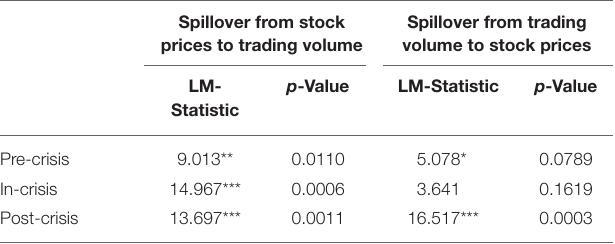
TABLE 3 | Result for causality in variance